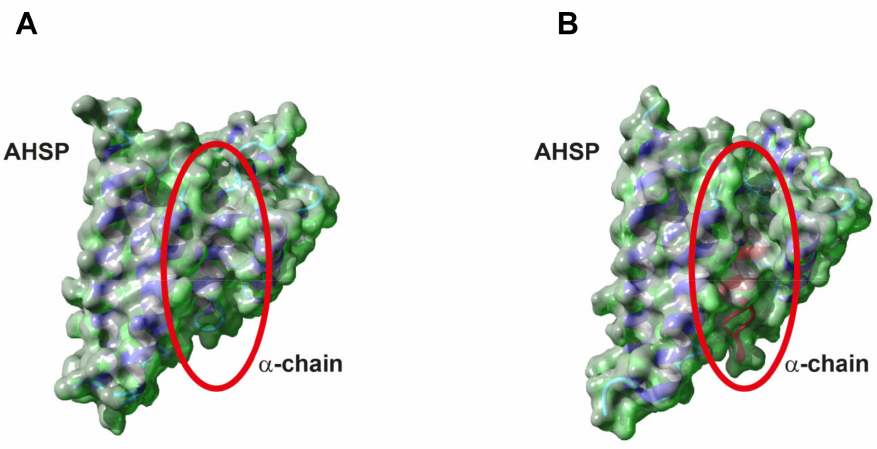
Figure 6. The 3D surface model of the Hb Sciacca. ( A ) The 3D surface model of the WT α -chain and of the Hb Sciacca ( B ) in complex with AHSP (PDB code 1Z8U). The red circles indicate the position of 23 mutated aa (in magenta) and the small cavity for the absence of the H helix in the Hb Sciacca ( B ) and the corresponding position in the WT ( A